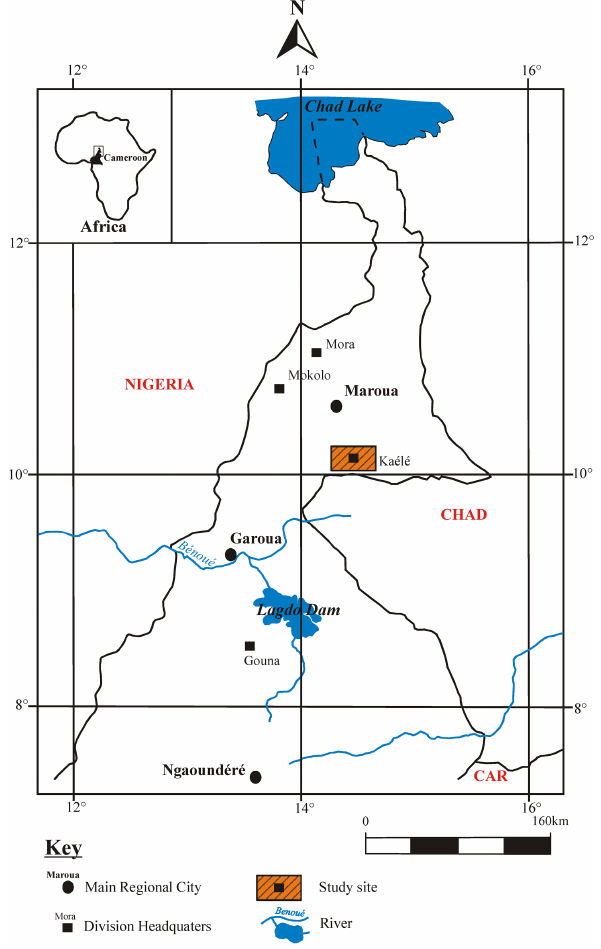
Figure 1. Location of the study